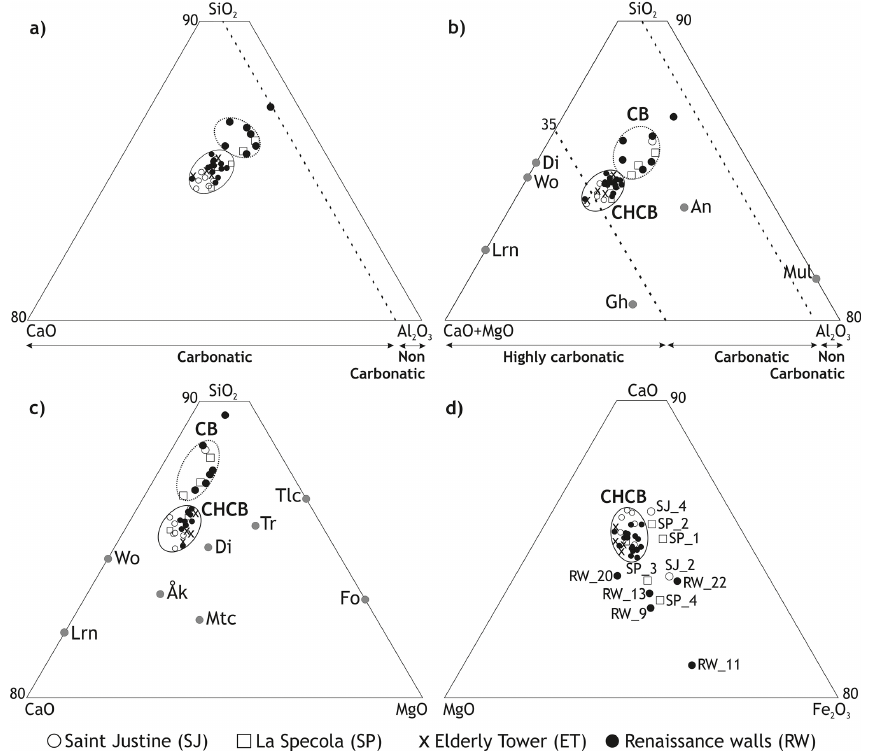
Figure 1. Plotting of the chemical composition of bricks in ternary diagrams. The samples are plotted within the carbonatic body (CB) and carbonatic-high carbonatic body (CHCB) groups (except RW_11). See Tables 2 and 3 for entire sample numbering. Panels (a) and (b) are adapted from Gliozzo (2020) and (c) from Trindade et al. (2009). Mineral abbreviations after Warr (2021): åkermanite (Åk), anorthite (An), diopside (Di), forsterite (Fo), gehlenite (Gh), larnite (Lrn), monticellite (Mtc), mullite (Mul), talc (Tlc), tremolite (Tr) and wollastonite (Wo).